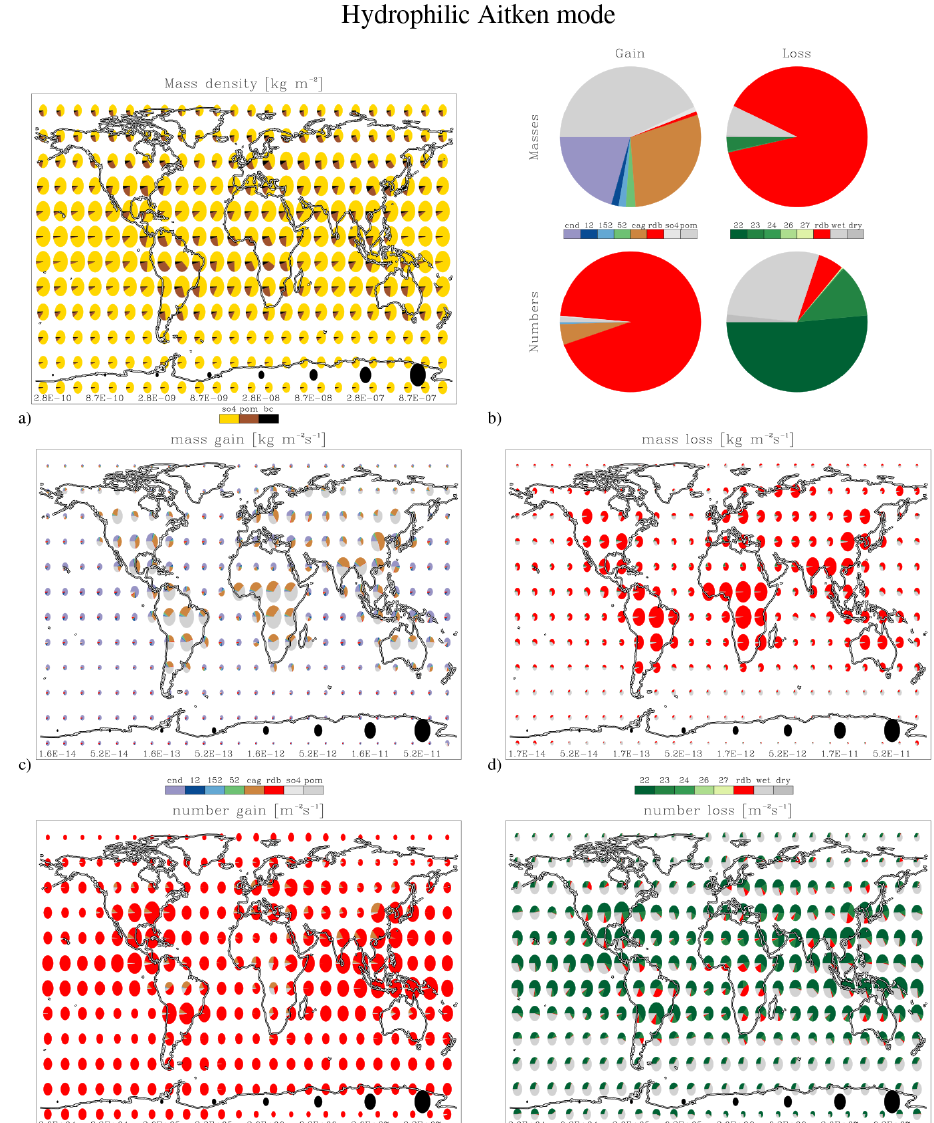
Figure 11. Global distribution of annual burdens (a) and tendencies ( b, c, d, e and f ) of the hydrophilic Aitken mode. The colors indicate either species (defined in Table 3) or processes (defined in Table 2). The pie chart shows fractional contributions, while the radius of the pie indicates total column burden or total column tendency (logarithmic scale as shown in black at the bottom of panels a, c, d, e and f ). Panel b shows a global average of the